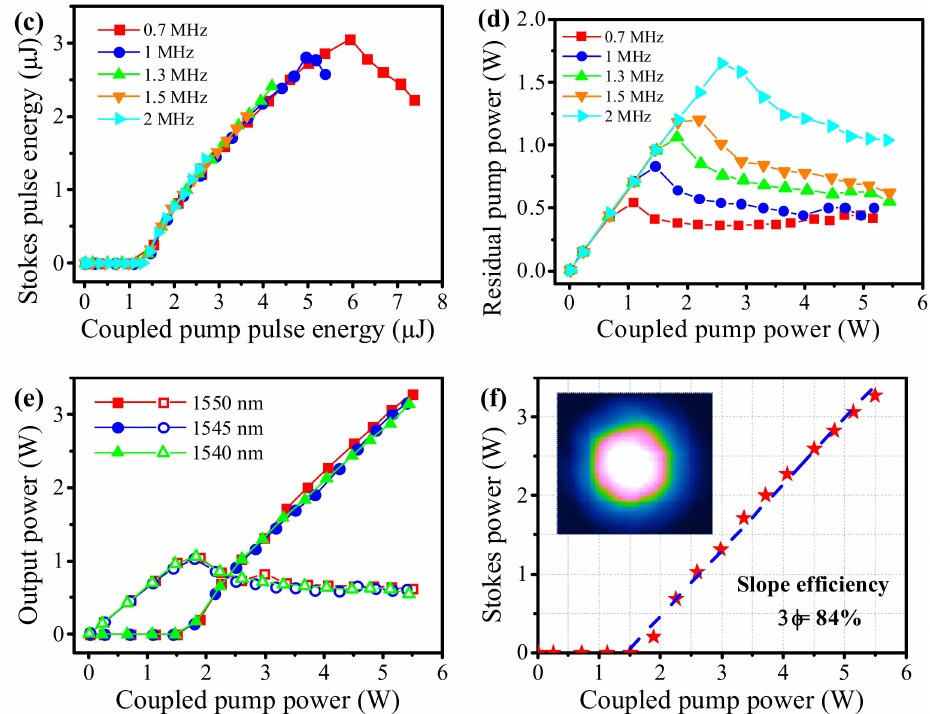
Figure 4. ( a ) The simulation and measured results of Stokes and residual pump powers at different repetition frequency when the pump power is 7.5 W and pump wavelength is 1540 nm, and dash lines and solid patterns represent the simulation and measured results respectively; The evolutions of ( b ) Stokes power, ( c ) Stokes pulse energy and ( d ) residual pump power with the coupled pump power/pulse energy at different repetition frequency when the pump wavelength is 1540 nm; ( e ) The evolutions of Stokes and residual pump powers with the coupled pump power at different pump wavelengths when the repetition frequency is 1.3 MHz, and solid and hollow patterns represent the Stokes power and residual pump power respectively; ( f ) For the highest Stokes laser emission at 1705 nm, the evolution of output Stokes power with coupled pump power. Insert: the near-field pattern of the Stokes